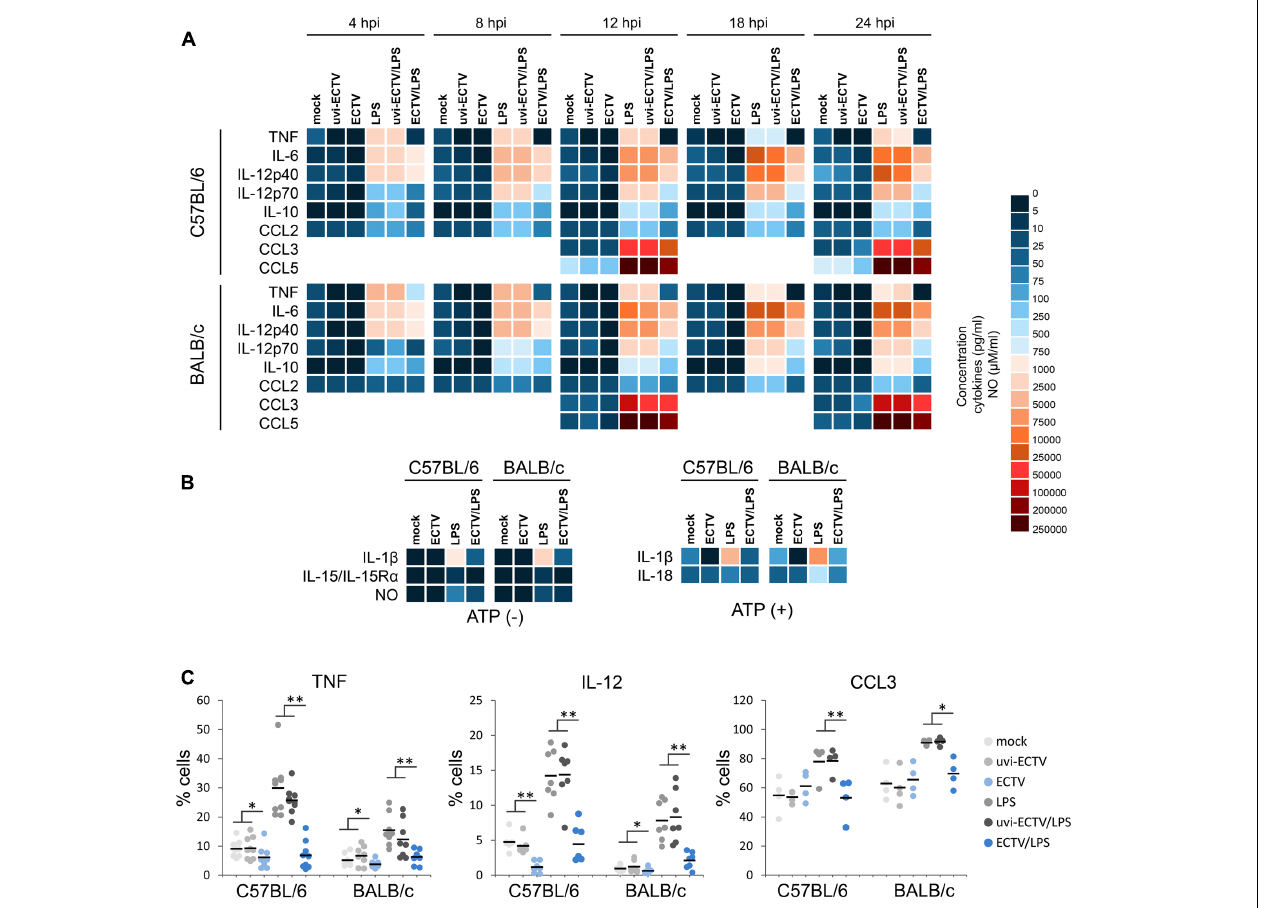
FIGURE 7 | The effect of ECTV infection on cytokine and chemokine synthesis and NO production by GM-BM is mouse strain-independent. Heat map represents mean concentration (pg/ml) values of cytokines and chemokines in culture supernatants of mock-, uvi-ECTV-, and ECTV-infected GM-BM, untreated or treated with LPS (A) , or additionally with ATP (B) . Mean NO concentration is presented as heat map ranging from 0 to 100 µ M/ml (B) . (C) The percentage of cytokine-producing GM-BM at 24 hpi with ECTV. Each point represents an individual data, with the bar indicating the mean values (paired Student’s t -test; ∗ P < 0.05, ∗∗ P <